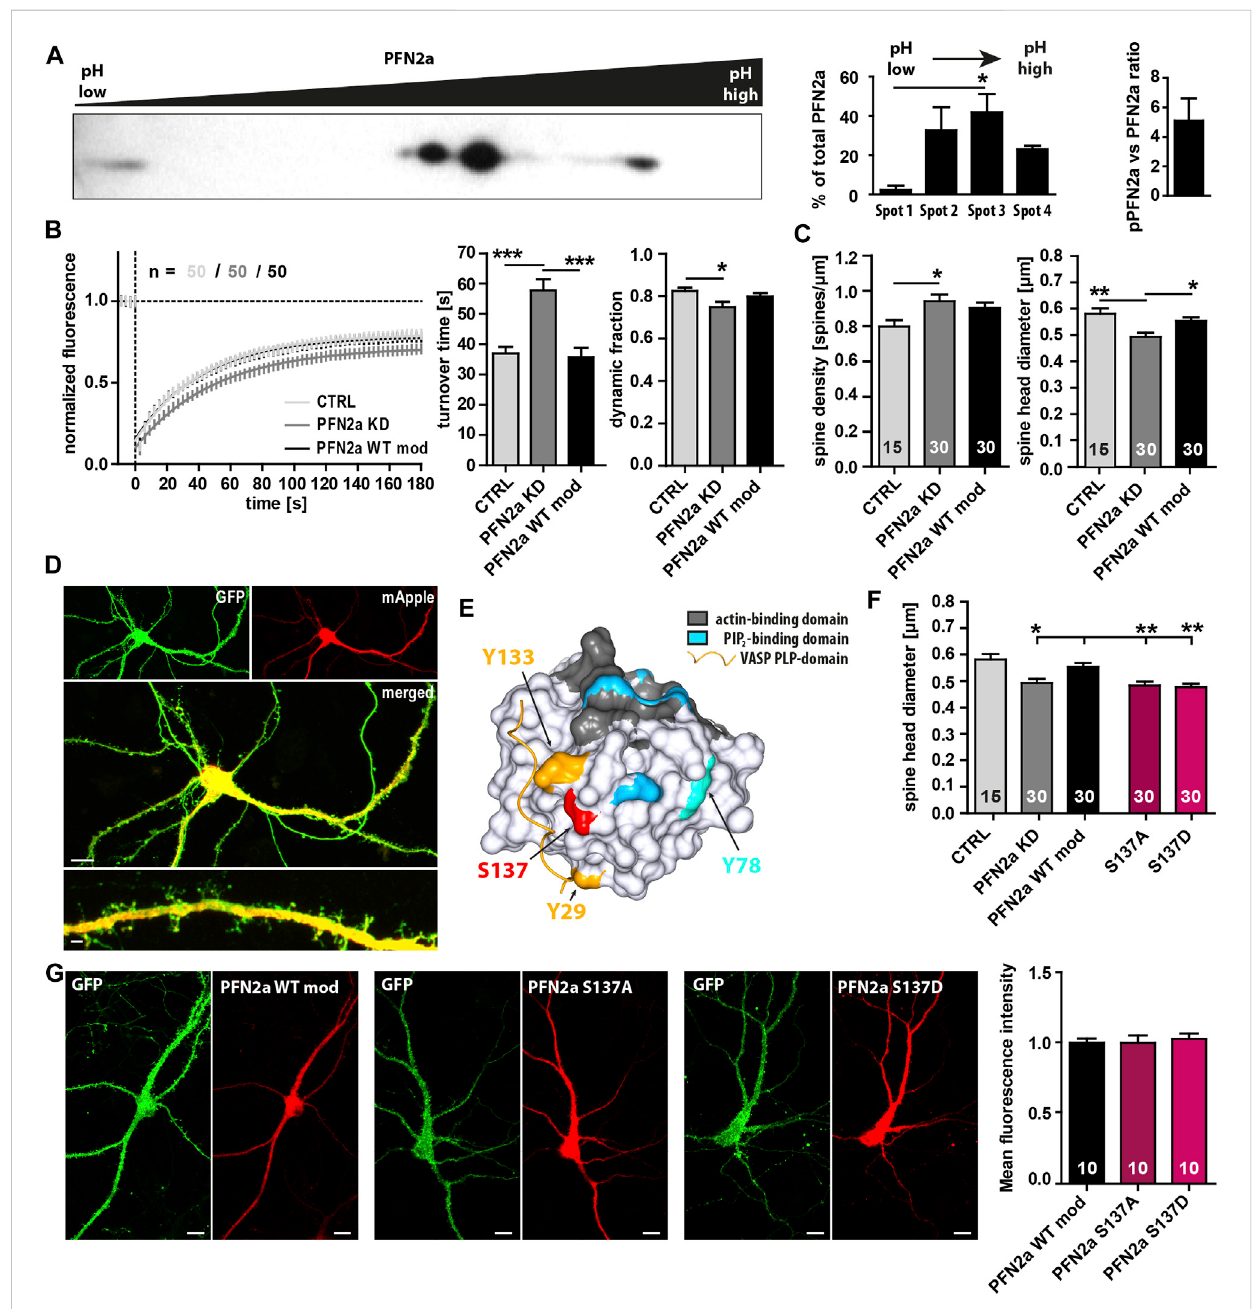
FIGURE 1 PFN2a modulates endogenous spine actin dynamics and dendritic spine morphology. (A) Separation of PFN2a by isoelectric point and molecular weight via 2D gel electrophoresiswith subsequent Western blotanalysisto depict thebasal phosphorylationstates of PFN2a. For voluminetricanalysis of spot intensity N = 3 gels. (B) Fluorescence Recovery After Photobleaching (FRAP) experiments of EGFP-ß-actin depicting basal actin dynamics in hippocampalneuronsafter23 daysinculture.Depictedaretherecoverycurvesoveratimecourseof180safterthebleachingpulseofhippocampal WT spines as well spines from neurons where PFN2a was knocked-down and replaced with either mApple (PFN2a KD) or wildtype PFN2a (PFN2a WT mod). In addition, the quanti fi cation of the turnover time as well as the fraction of dynamic actin is depicted (resembling the amount of fl uorescence which recoveredinthetime periodof180safter thephotobleach). n =50dendriticspineseach.N=3experiments. (C) Analysis ofdendriticspine density and dendritic spine head diameter in hippocampal WT control, PFN2a knockdown as well as PFN2a WT mod re-expressing neurons. n = 15, 30, 30 dendrites respectively (1 dendrite was analyzed per neuron). N = 3 experiments. (D) Example images depicting a hippocampal neuron where PFN2a was knocked down as indicated byexpressionof mApple. Scale bars- 10 µm(middle), 2 µm (bottom). (E) PFN2a surface model indicating the location of the known phosphorylable amino acids Y29 (yellow), Y78 (light blue), Y133 (yellow) and S137 (red) that were targeted for the generation of PFN2a phospho- and dephospho-mimetic mutants. To highlight their close proximity to known binding domains, the PFN2a actin-binding domain (grey), the PIP2-binding domain(blue)as wellasthePLP-binding domain(indicated via aVASP PLP-domain,yellow) weremarkedaswell. (F) Analysis oftheaverage dendritic spine head diameter of hippocampal neurons where endogenous PFN2a was replaced with one of the different PFN mutants. n = 15 (Ctrl), 30 (KD),30(WTmod),30(S137A),30(S137D)(1dendritewasanalyzedperneuron).N=3experiments. (G) AnalysisofmApplemean fl uorescenceintensityin the cell body of transfected hippocampal neurons where endogenous PFN2a had been replaced by PFN2a WT mod, S137A or S137D (9 days post- transfection). Example images depict individual neurons co-transfected with EGFP and the different mApple-tagged PFN2a variants. Scale bars - 10